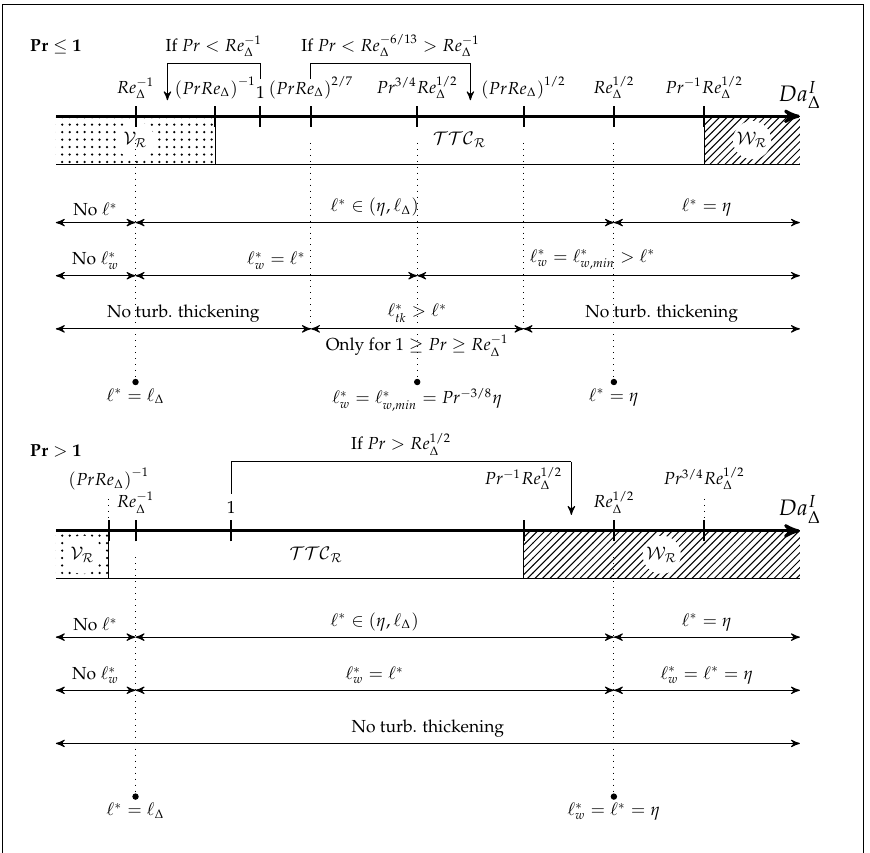
Figure 3. Description of the turbulent combustion regimes in the LTSM framework. Surviving, wrinkling, and thickening eddy scales are also reported. The non-dimensional groups of the Da I ∆ axis reported above the others for Pr > 1 are those who changed their position with respect to the Pr ≤ 1